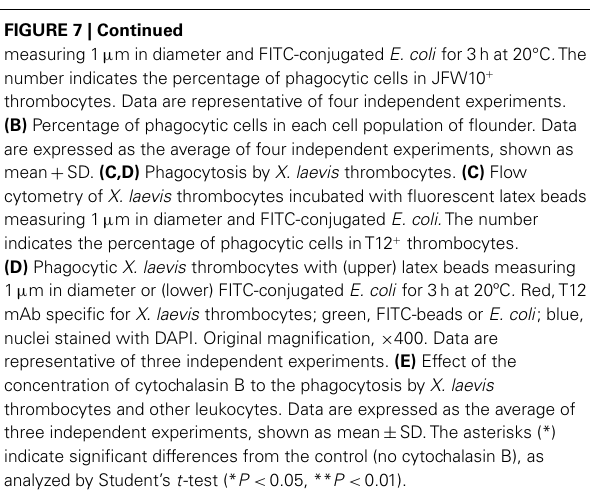
FIGURE 7 | Continued measuring 1 µ m in diameter and FITC-conjugated E. coli for 3h at 20°C . The number indicates the percentage of phagocytic cells in JFW10 + thrombocytes. Data are representative of four independent experiments. (B) Percentage of phagocytic cells in each cell population of flounder. Data are expressed as the average of four independent experiments, shown as mean + SD. (C,D) Phagocytosis by X. laevis thrombocytes. (C) Flow cytometry of X. laevis thrombocytes incubated with fluorescent latex beads measuring 1 µ m in diameter and FITC-conjugated E. coli. The number indicates the percentage of phagocytic cells inT12 + thrombocytes. (D) Phagocytic X. laevis thrombocytes with (upper) latex beads measuring 1 µ m in diameter or (lower) FITC-conjugated E. coli for 3h at 20ºC .